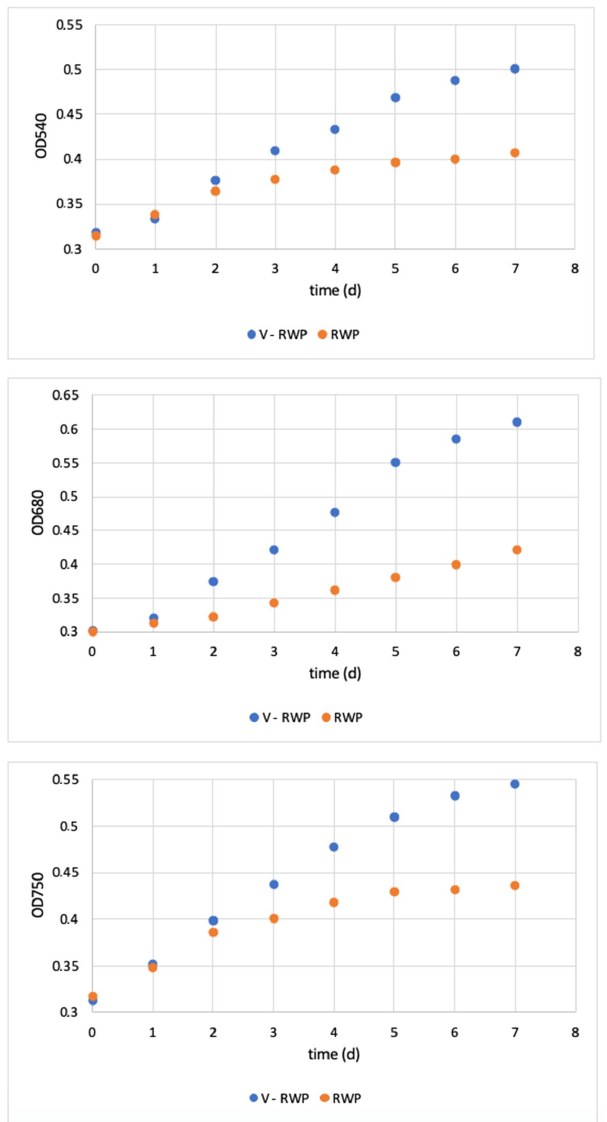
Figure 12. Growth of Chlorella vulgaris in V—RWP and conventional RWP monitored at three wavelengths; 540 nm, 680 nm and 750 nm. Table 4. Mean L/D cycle frequencies (s − 1 ) obtained for the uppermost, neutral and lowermost cylin- der positions.